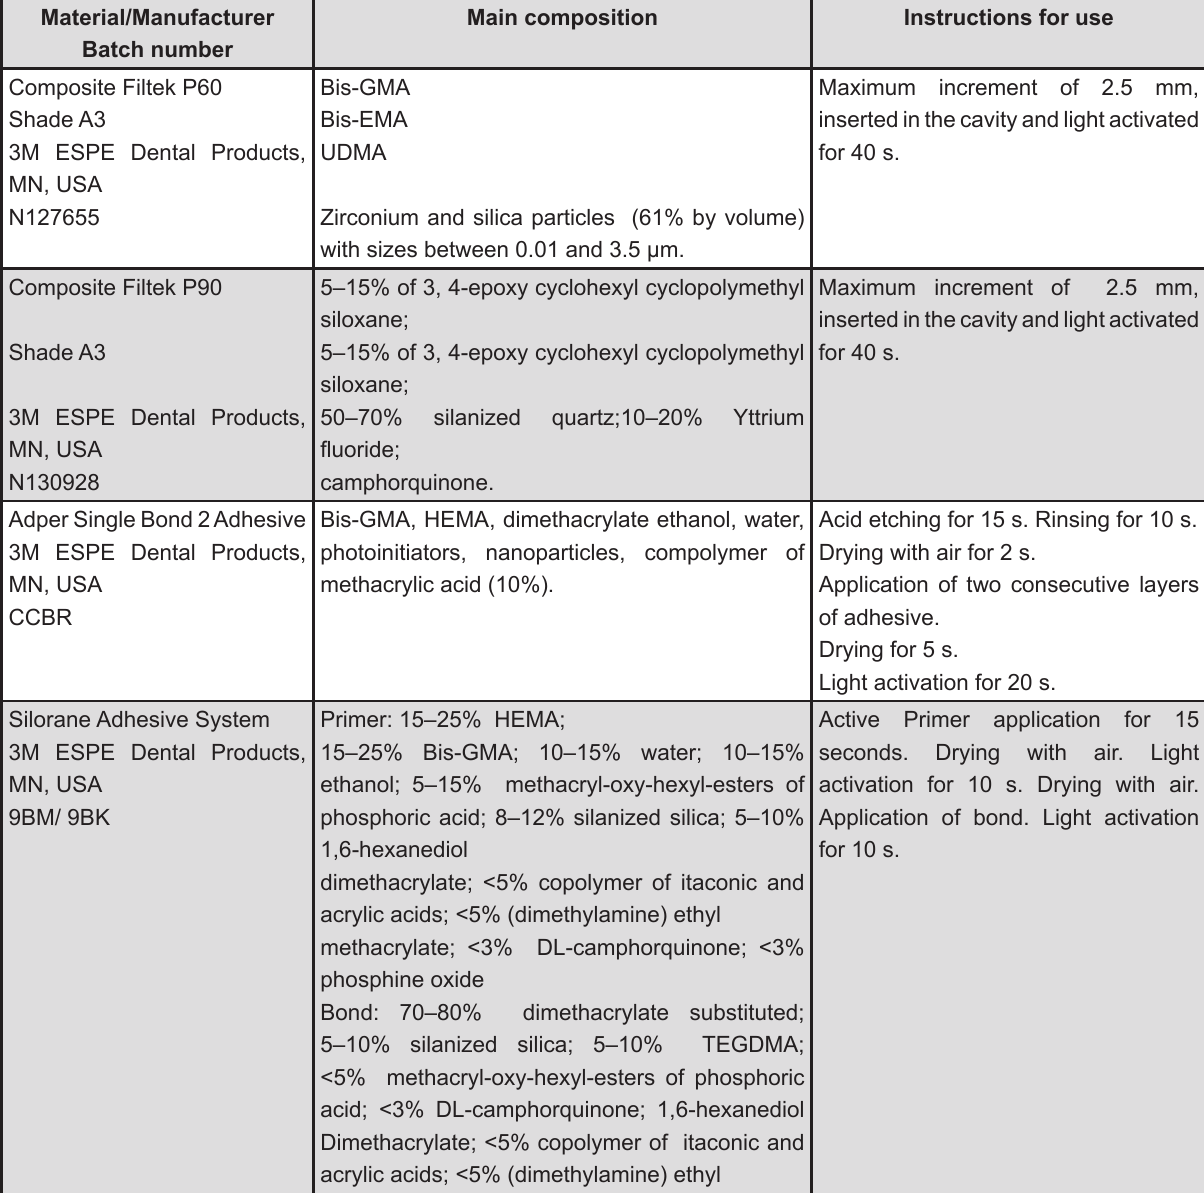
Figure 1- Lots, manufacturers, main components and instructions for use of resin composites and adhesive systems